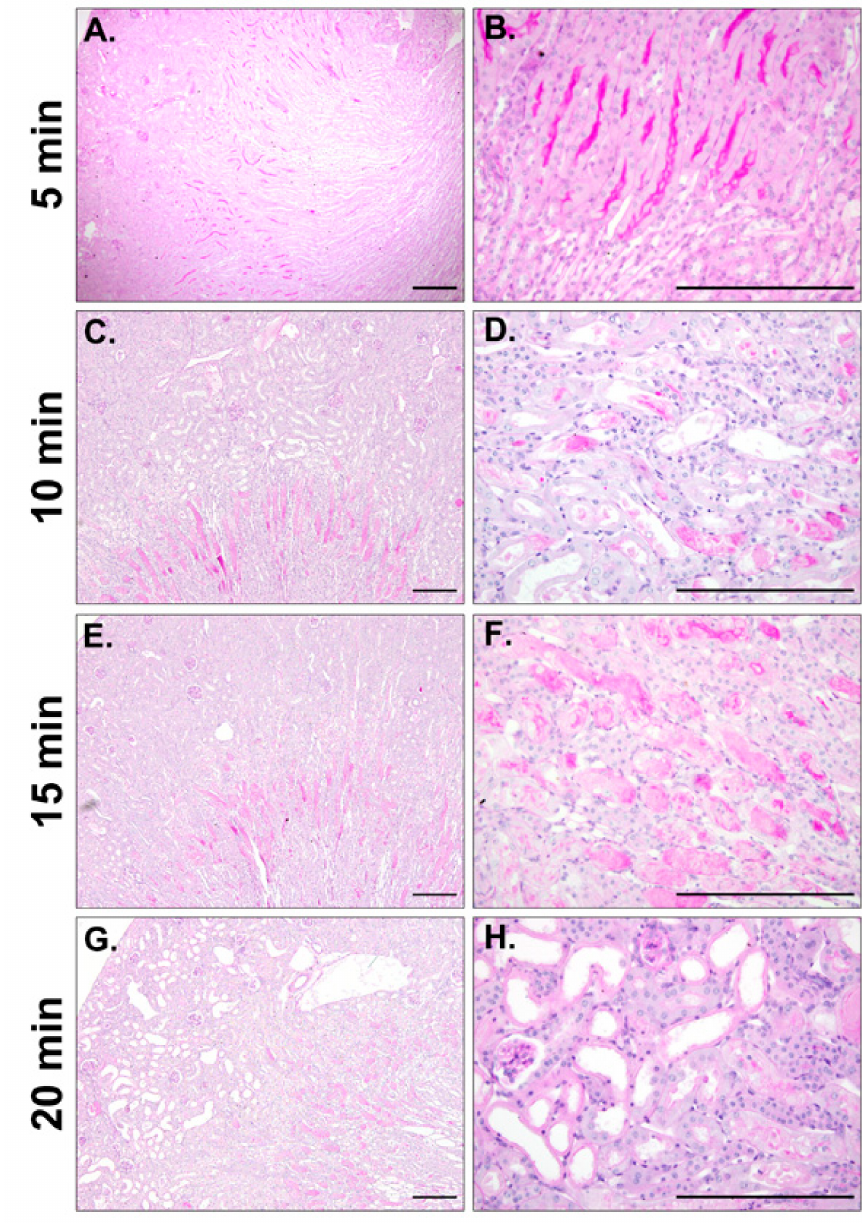
Figure 6. Representative images of the tubular modifications obtained after 5 to 20 min of ischemia. The kidneys were collected 24 h after ischemia and stained with Schiff’s periodic acid staining. A 5-min ischemia ( A , B ) induced no visible alteration of renal histology: the brush border was still visible in all the proximal tubules and no apoptotic cells or casts were observed. After a 10-min ( C , D ) or 15-min ischemia ( E , F ), a loss of the brush border, a thinning of the epithelium and casts were observed at the corticomedullary junction. After 20 min of ischemia ( G , H ), additional cortical dilations were seen. Scale bar: 200 µ